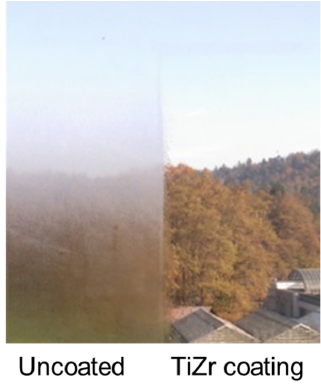
Figure 18. Antifogging effect of uncoated and TiZr coated glass. (Reprinted/adapted with permission from Ref.